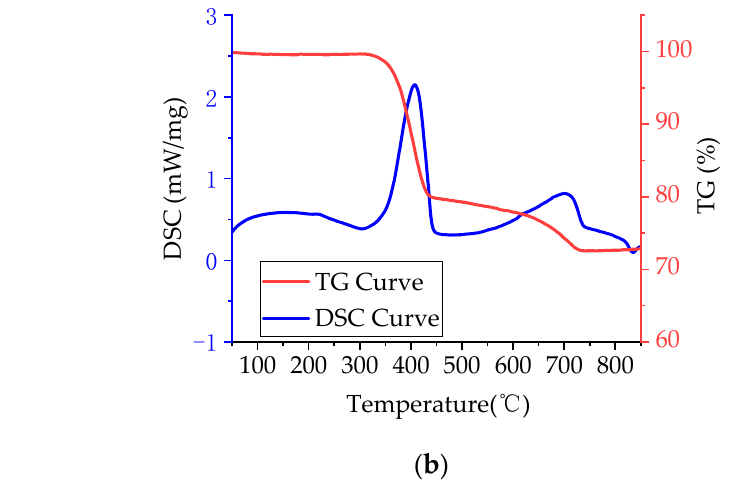
Figure 3. Thermal analysis curves of pure FR: ( a ) TG-DTG curve; ( b ) TG-DSC curve.